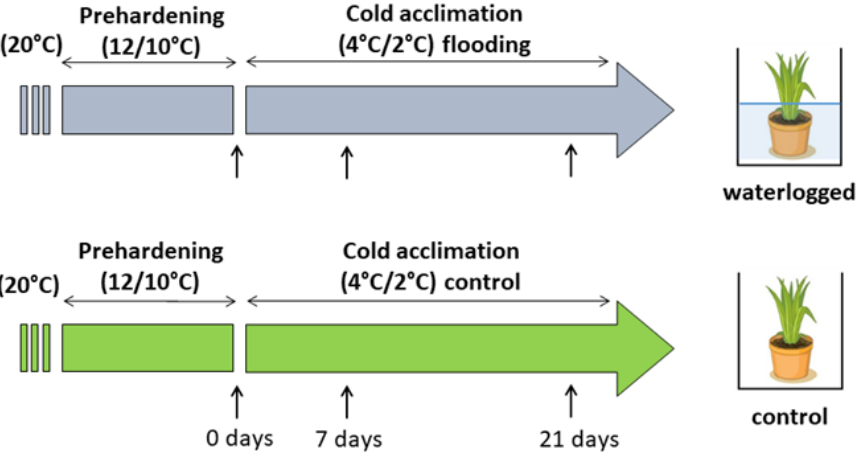
Figure 15. Schematic illustration of the experimental design and treatments. Sampling time points are indicated by arrows.